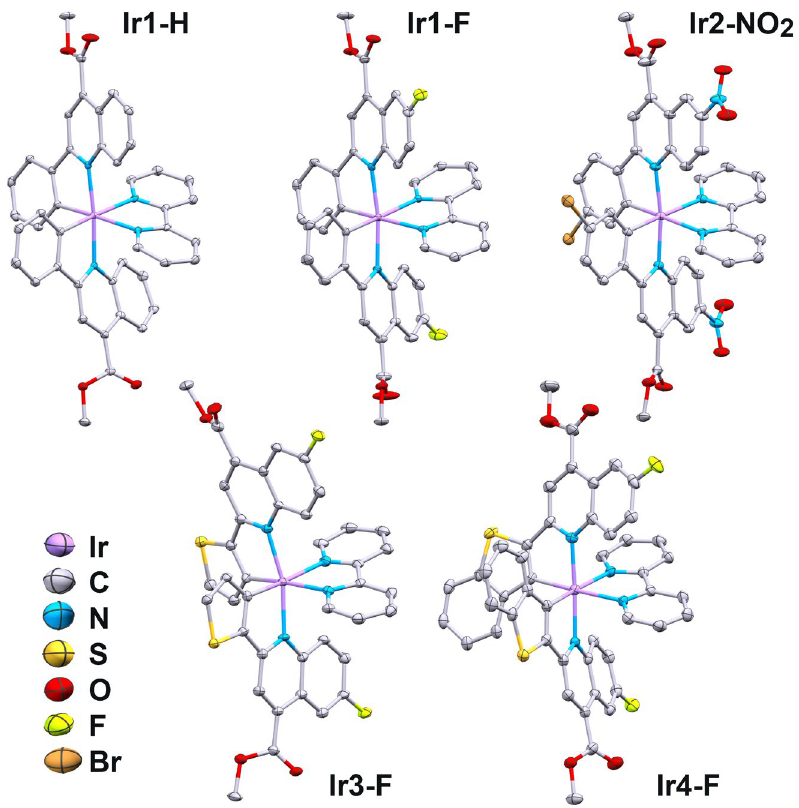
Figure 1. Perspective views of Ir1-H, Ir1-F, Ir2-NO 2 , Ir3-F, Ir4-F. Thermal ellipsoids are shown at the 40% probability level. Hydrogen atoms and counterions (PF 6 ) are omitted for clarity.